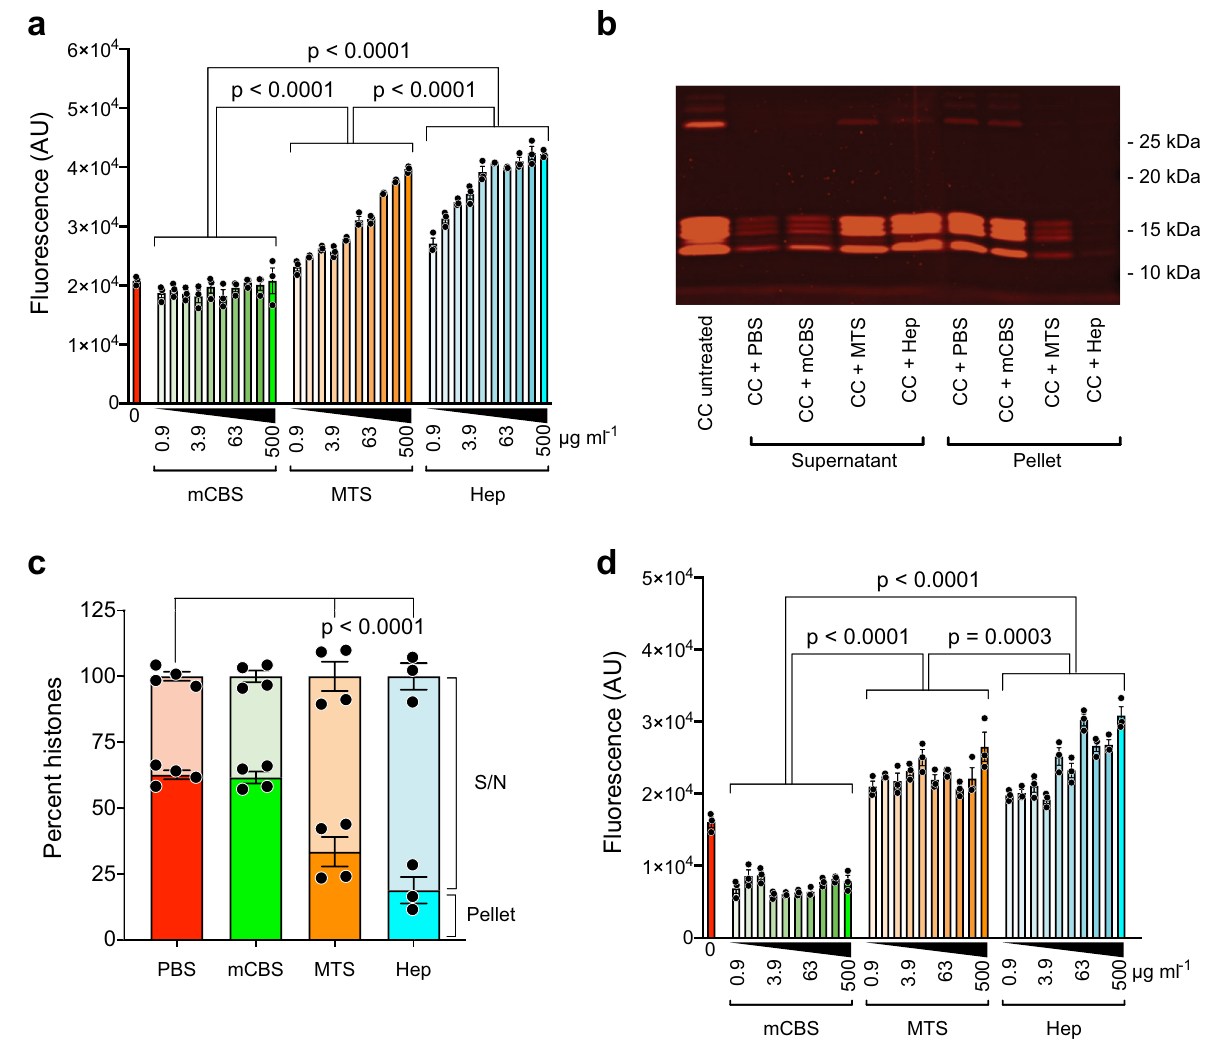
Fig. 8 Polyanion-induced changes in chromatin and NETs. a Enhanced uptake of the fl uorescent DNA-speci fi c dye, Sytox Green, by chicken chromatin (CC) following exposure to the polyanions MTS and heparin, but not mCBS at concentrations ranging from 0.9 to 500 µ gml − 1 ( n = 3/treatment). Data suggest that MTS and heparin can displace histones from CC over a wide concentration range, whereas mCBS cannot. b CC exposed to 500 µ gml − 1 of mCBS, MTS, and heparin, pelleted by centrifugation, and supernatants and pellets collected and run on SDS-PAGE. Representative data from one gel (137% normal size), con fi rming that MTS and heparin can displace histones from CC, whereas mCBS cannot. c Histogram including all the SDS-PAGE data and showing that MTS and heparin displace histones from CC, an effect that is signi fi cant ( n = 4/treatment). d Sytox Green uptake by human NETs following incubation with mCBS, MTS, and heparin as in b above ( n = 3/treatment). Data similar to that obtained with CC incubated with MTS and heparin. However, unlike CC, mCBS reduced Sytox Green uptake by NETs by ~50%, suggestive of NET stabilization. Solid circles are individual data points and are presented as mean±s.e.m. and analyzed by two-way ANOVA with Tukey ’ s correction for multiple comparisons. Source data are provided as a Source Data